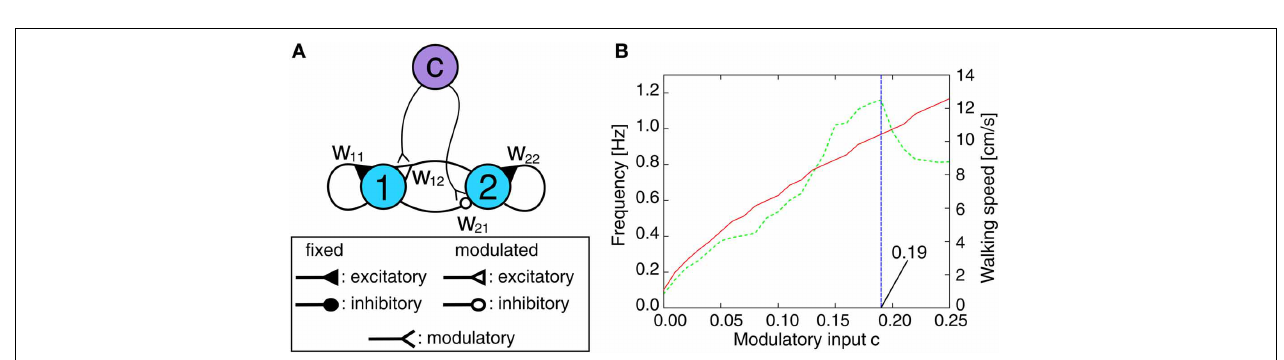
which signal σ BJ directly drives the backbone joint. (B) Behavior-based, hierarchical topology of BJC. Lower ordered behaviors are surpressed through inhibitory synapses.